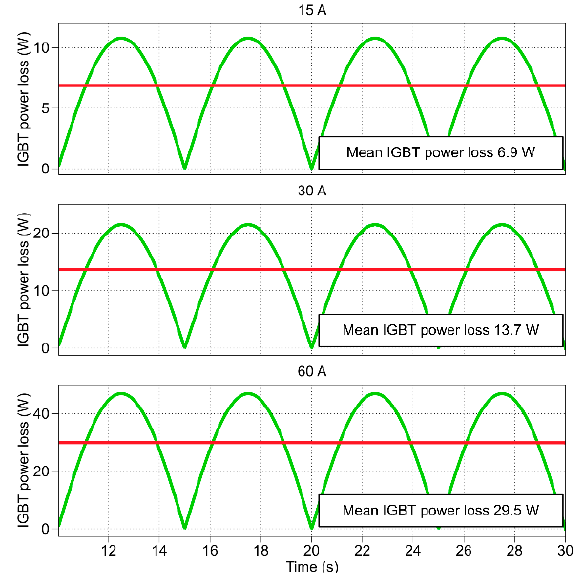
Figure 13. IGBT power losses averaged by the switching frequency at 15, 30, and 60 A.